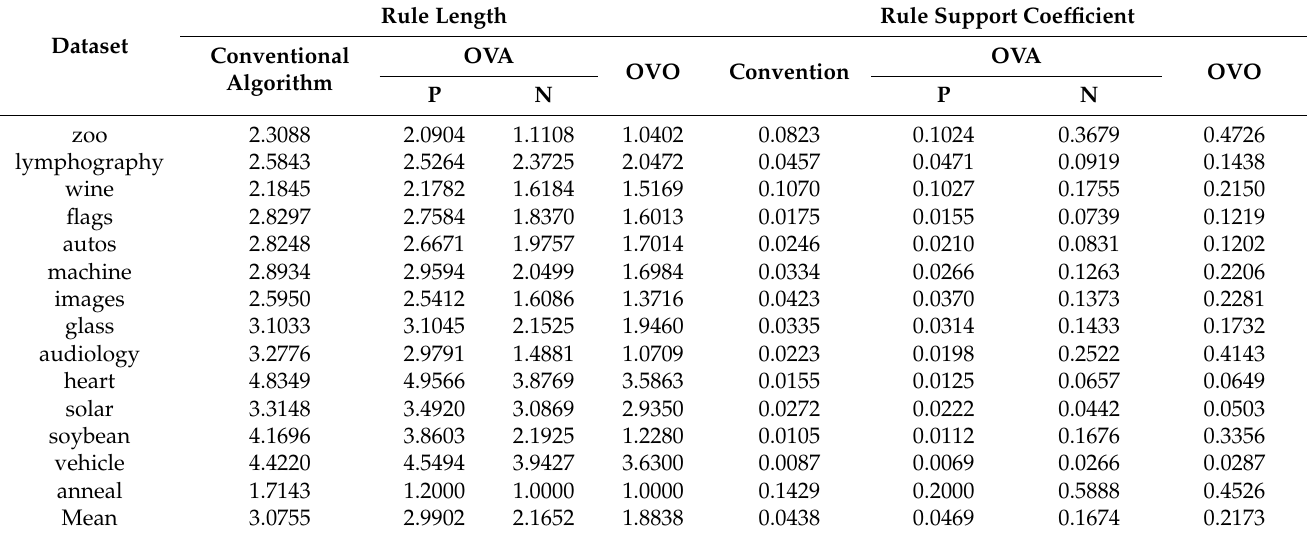
Table 5. Length and support coefficient of rules obtained by different